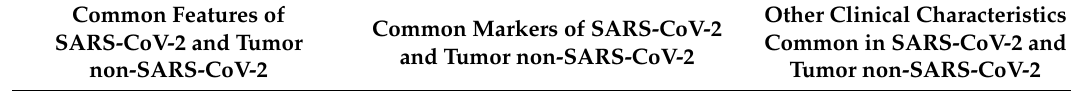
Other Clinical Characteristics Common in SARS-CoV-2